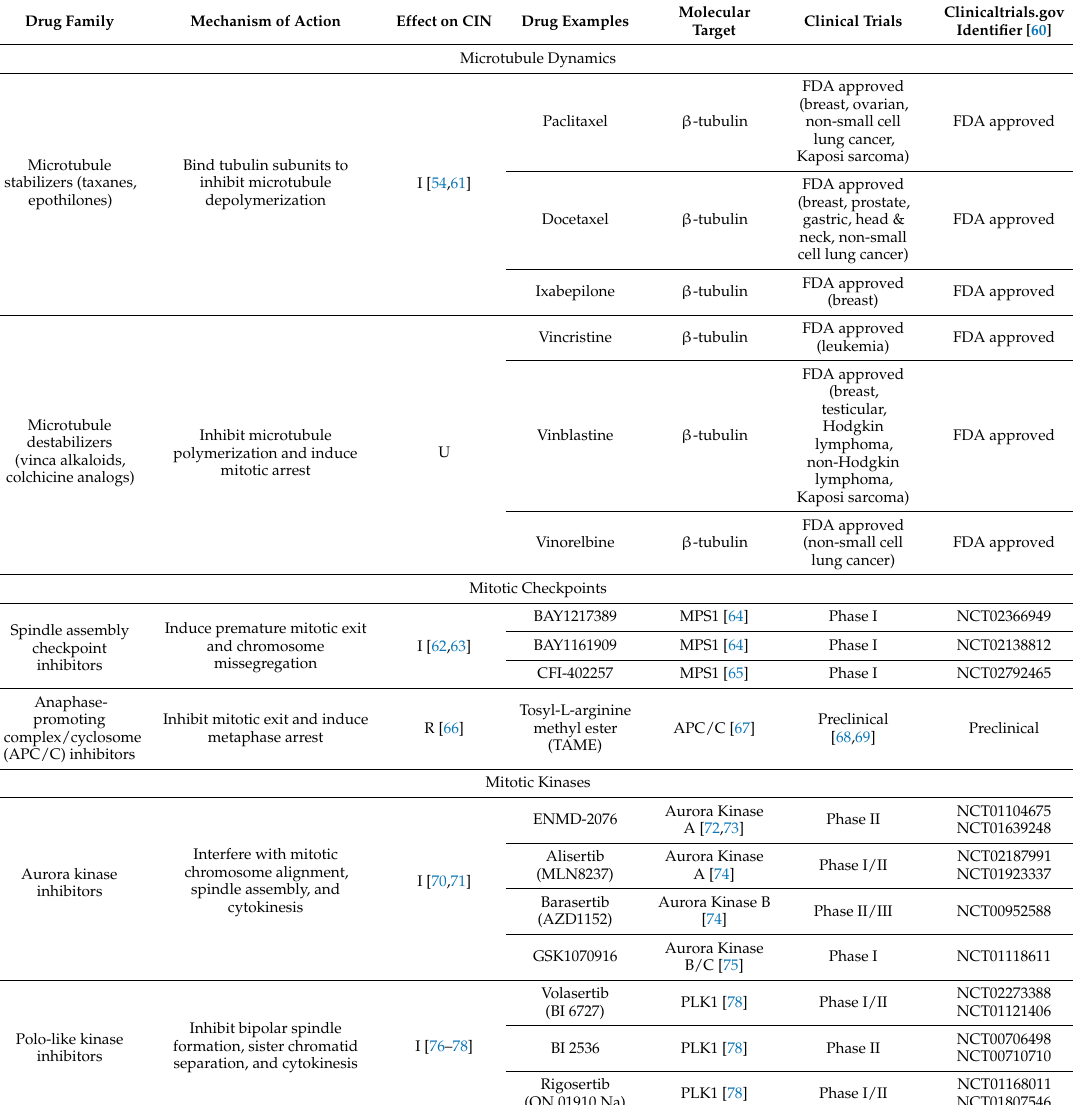
Table 2. Classes and Mechanisms of Numerical CIN-Inducing and -Reducing